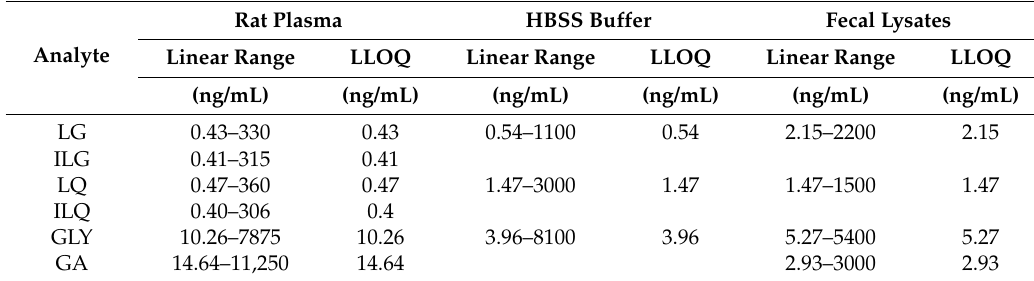
Table 5. Linear ranges and LLOQs of analytes in different biological